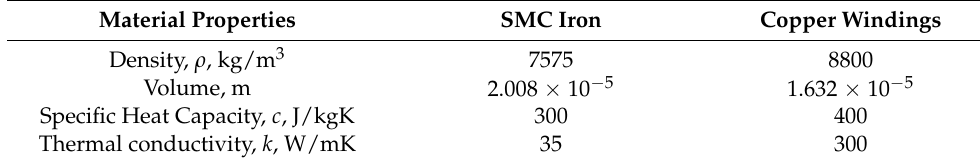
Figure 5. 3D CAD geometry and Boundary conditions for the single channel.